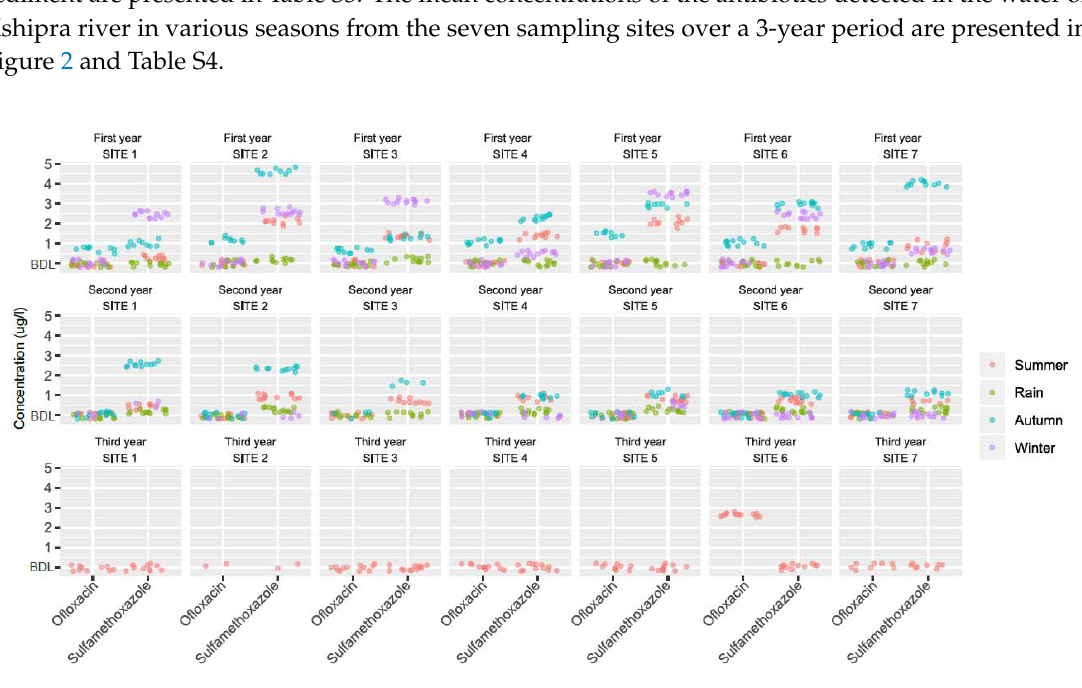
Figure 2. Concentrations of antibiotic residues measured in waters of the Kshipra river in India in various seasons and at various sites over a 3-year period. Note: significant ( p < 0.05) seasonal and spatial variations in the occurrence of sulfamethoxazole and ofloxacin were found over a 3-year period. Information for all antibiotics is available in Table S4.